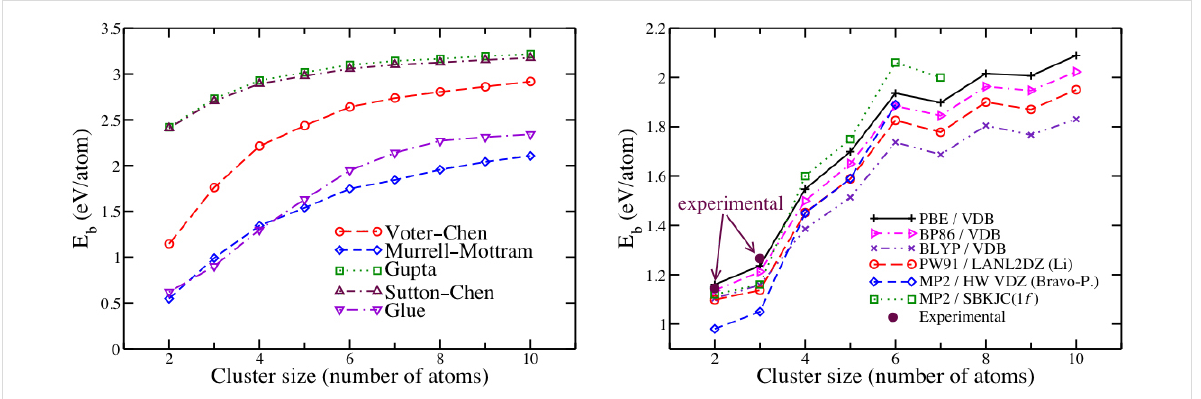
Figure 11: Left: Binding energies calculated for Au 2 –Au 10 clusters using different empirical potentials. The values correspond to the global minimum energy structures, which are always non-planar (except for Au 2 and Au 3 ). Right: Binding energies obtained using DFT and MP2 calculations, compared to DFT values reported by Li [81], to MP2 values reported by Bravo-Perez [82], and to experimental values reported by Bishea and Morse [83,84]. All structures are planar (MP2 global minimum energy structure for Au 7 is non-planar, but here we show the value corresponding to the planar structure). For Au 3 , the structure reported by Bravo–Perez is the equilateral triangle.